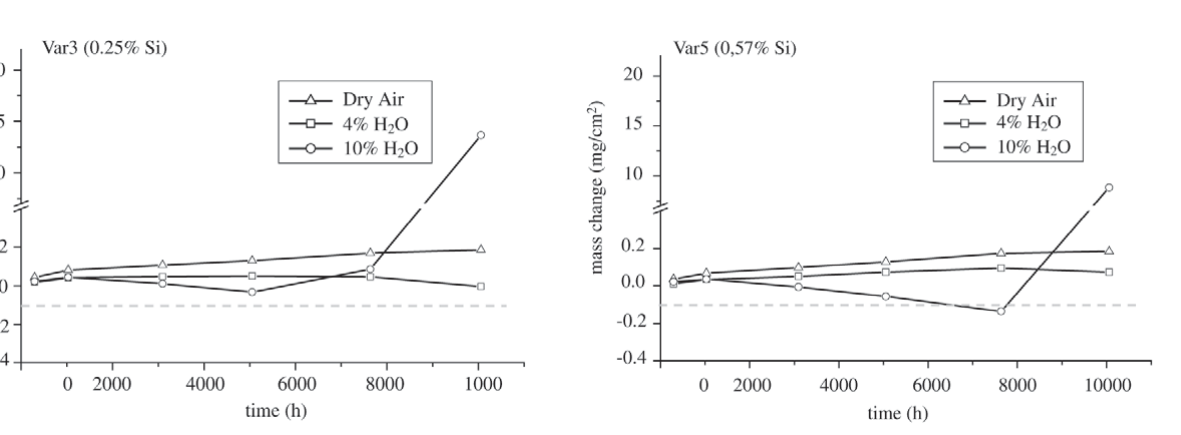
Figure 9. Results of mass change measurement as a function of time for Variation 5 of Nf616 at 650 °C in different